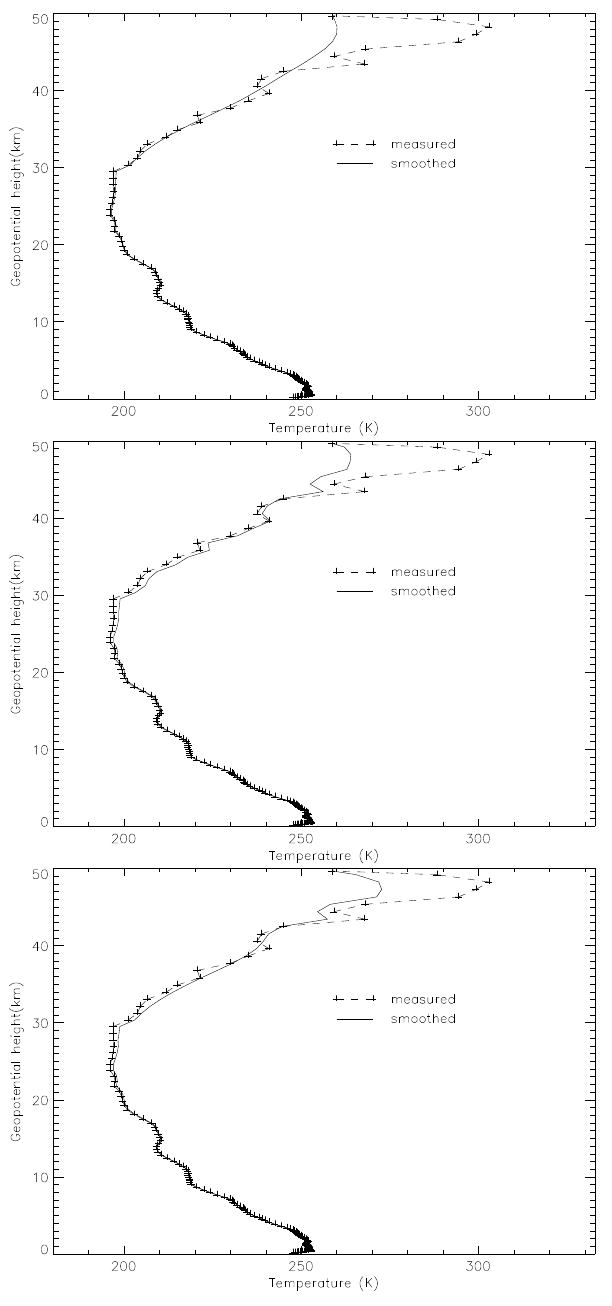
Fig. 6. The retrieved temperature profiles corresponding to the smoothed bending angle profiles given in Fig. 3.